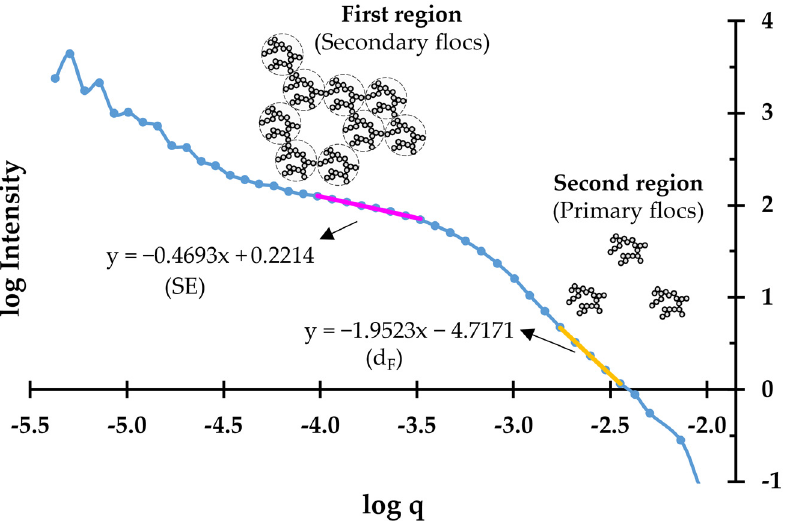
Figure 2. Example of the log-log plot of scattering light intensity versus q for the determination of the scattering exponent, SE (first region), and the fractal dimension, d F (second region).